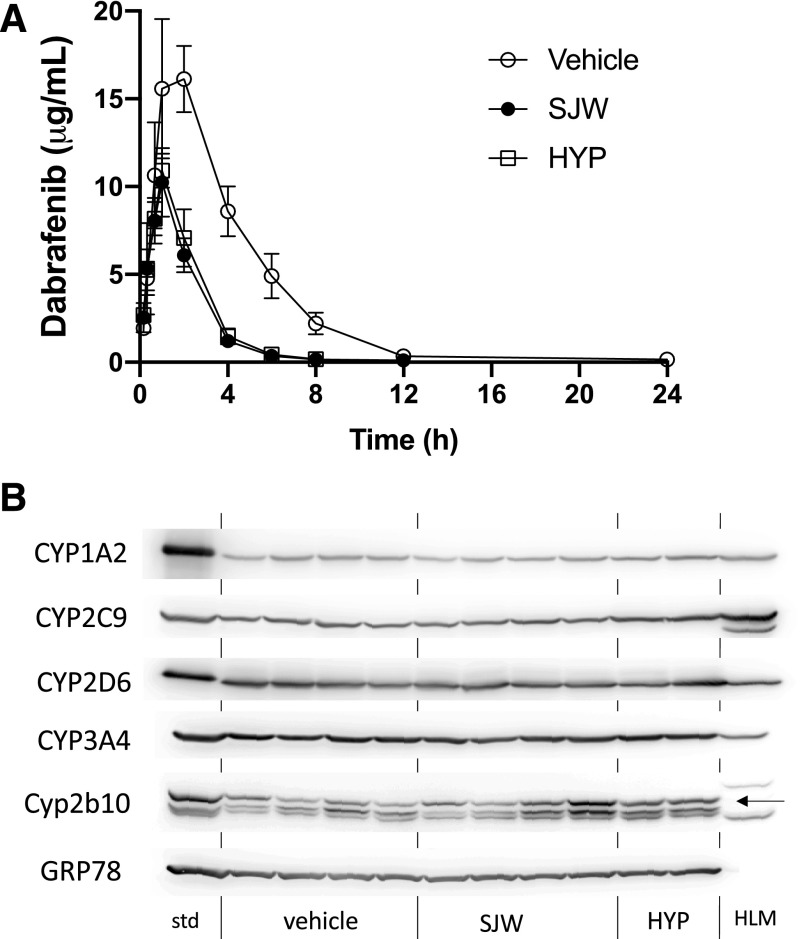
Effect of St. John’s Wort and hyperforin on pharmacokinetics. (A) Female 8HUM mice (n = 2–4) were treated with vehicle (open circles), St. John’s Wort (closed circles) or hyperforin (HYP; open squares) for 2 days as described before being dosed with dabrafenib for PK profiling as described in the Materials and Methods. Data are shown as mean ± S.D. (B) Liver microsomes from the 8HUM mice treated in (A) with vehicle, St. John’s Wort (SJW), or hyperforin (HYP), and also subject to dabrafenib PK profiling, were immunoblotted against CYP3A4 and Cyp2b10. Arrow indicates position of Cyp2b10 band. GRP78 was used as a loading control.